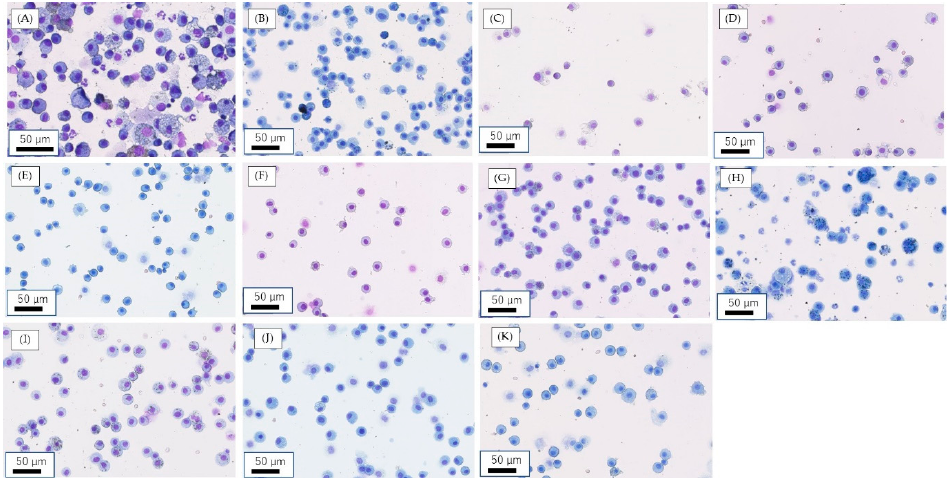
Figure 1. Inflammatory cells in bronchoalveolar lavage fluid (BALF) with cytospin at 6 months following intratracheal instillation and at 3 months following inhalation exposure. ( A ) Instillation of 1.0 mg NiO; ( B ) instillation of 1.0 mg CeO 2 ; ( C ) instillation of 1.0 mg TiO 2 (P90); ( D ) instillation of 1.0 mg TiO 2 (rutile); ( E ) instillation of 1.0 mg ZnO; ( F ) negative control in intratracheal instillation